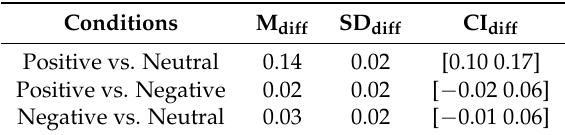
Table A16. Paired two-sample bootstrap test of significance (10,000 simulation runs) at 95.0% confidence interval (CI) applied on the participants’ PE7s (i.e., 62 PE7s associated with 62 EEG channels of a participant, per affect). Compared pairs of mental states are: positive versus neutral, positive versus negative, and negative versus neutral. M: mean difference, SD: standard deviation of such a difference. CI: 95% confidence interval for every paired affective states’ difference.